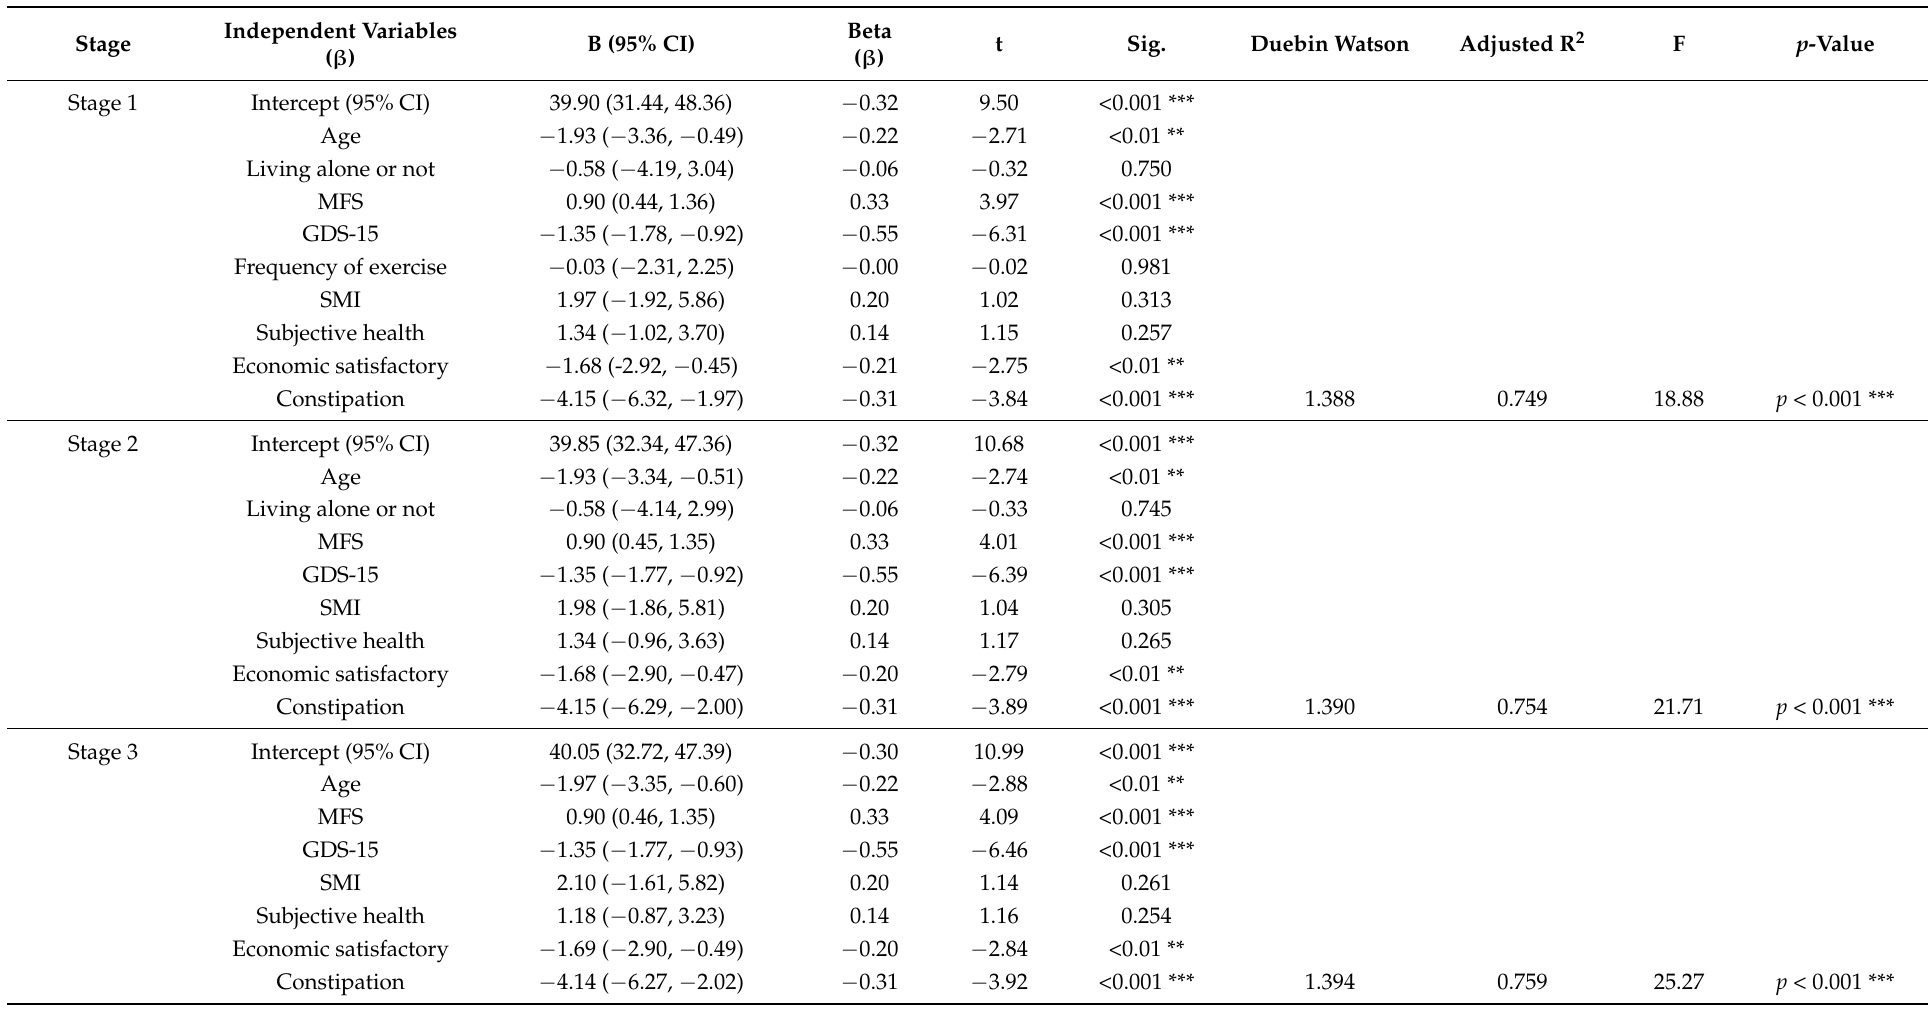
Table 4. Multiple regression analysis between independent variables and